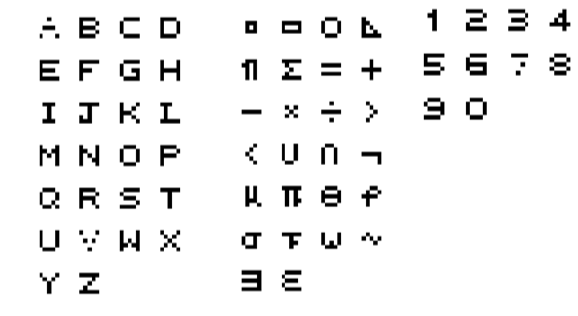
Figure 7 Test Image Generated for OCR